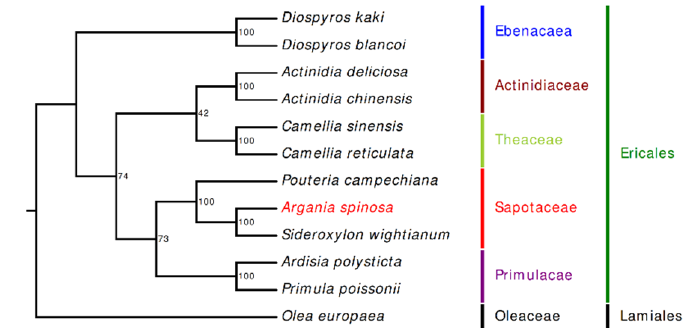
Figure 8. Phylogenetic tree reconstruction of 12 taxa using the maximum likelihood (ML) method based on 69 shared protein sequences. The number above each node indicates the bootstrap support values. Olea europaea was used as an outgroup.